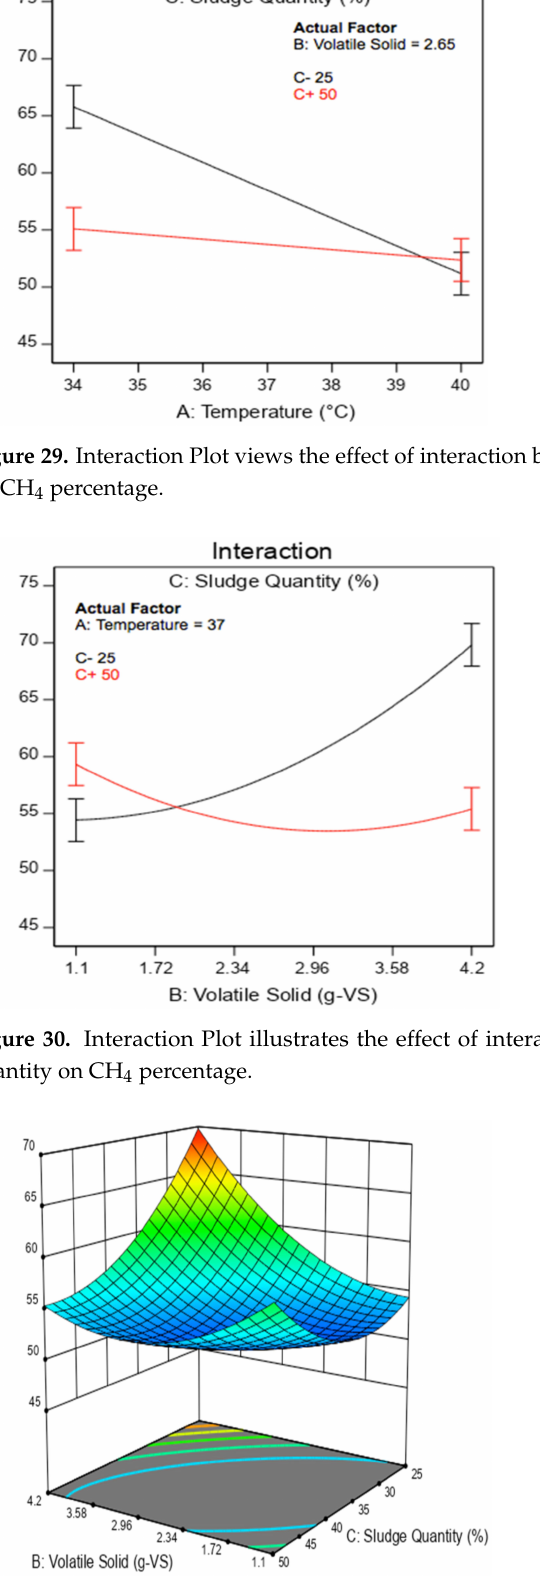
Figure 31. 3-D surface Plot shows the effect of volatile solid and sludge quantity on the CH 4 % at 37 ◦